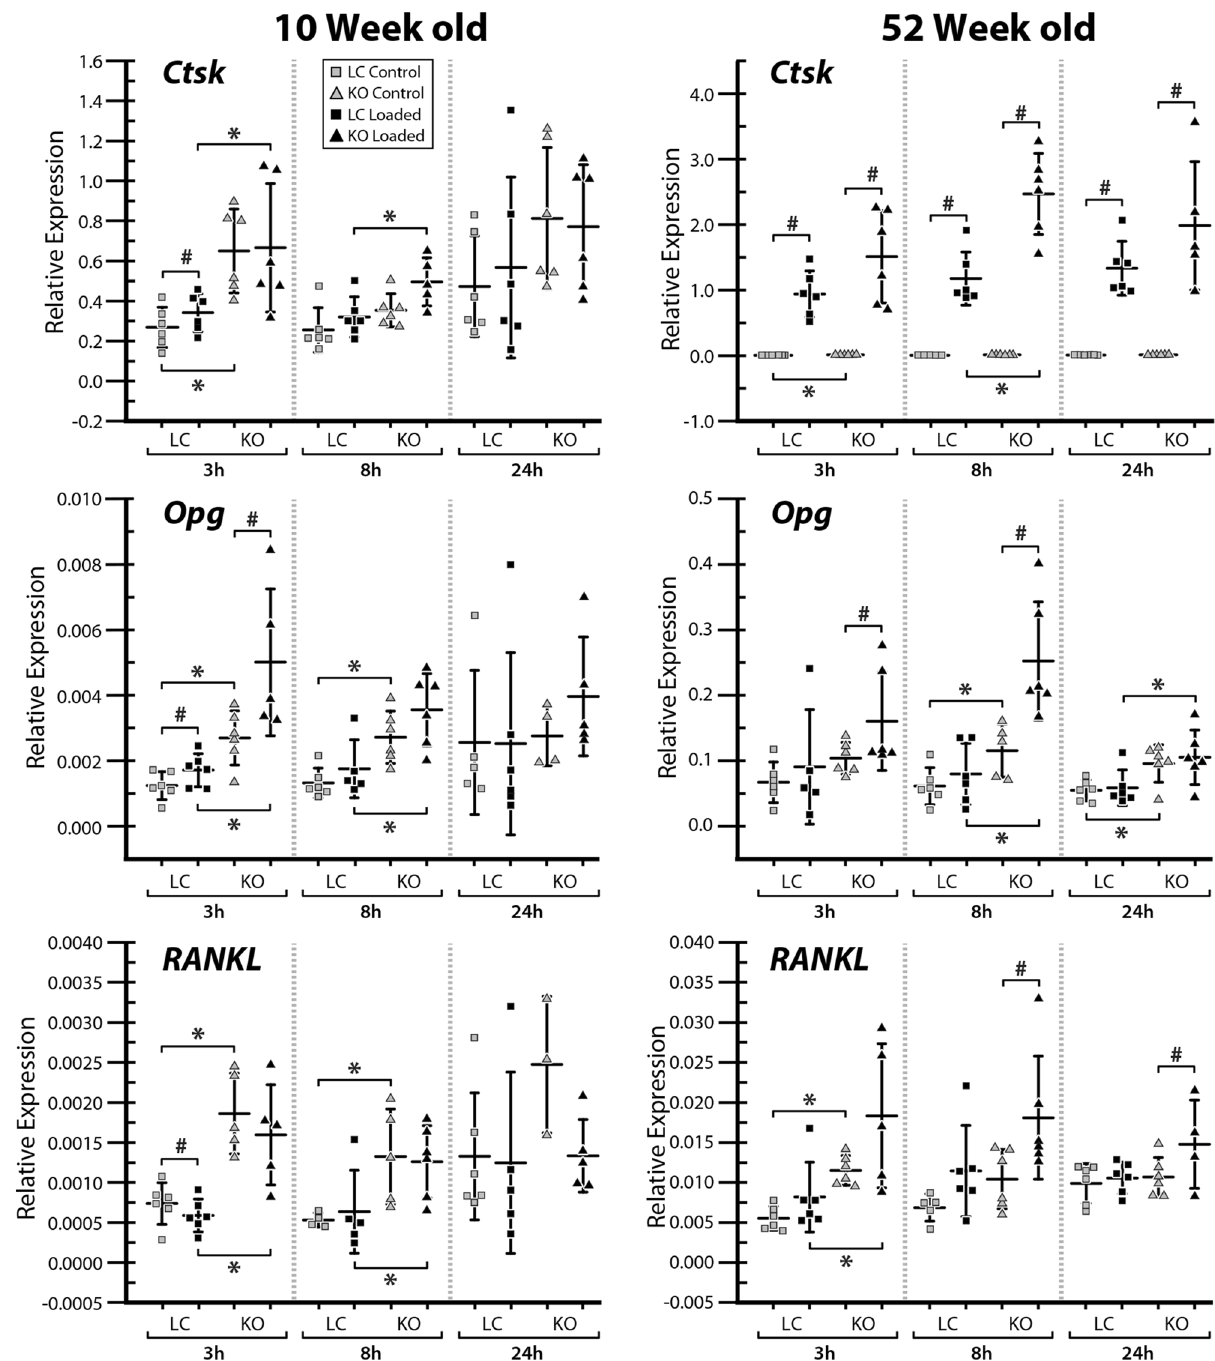
Figure 7. Gene expression of Ctsk , Tnfrsf11b (= Opg ) and Tnfsf11 (= RANKL ) was measured at 3, 8, and 24 h after a single loading session in the left loaded and right control tibiae of 10- and 52-week-old male Sost KO and LC mice. Gene expressions relative to reference genes are shown. *Indicates a significant difference between Sost KO compared to LC for each condition (t-test; p < 0.05). # Indicates a significant difference between loaded and control bones for each condition (paired t-test; p < 0.05). Sample size: n =